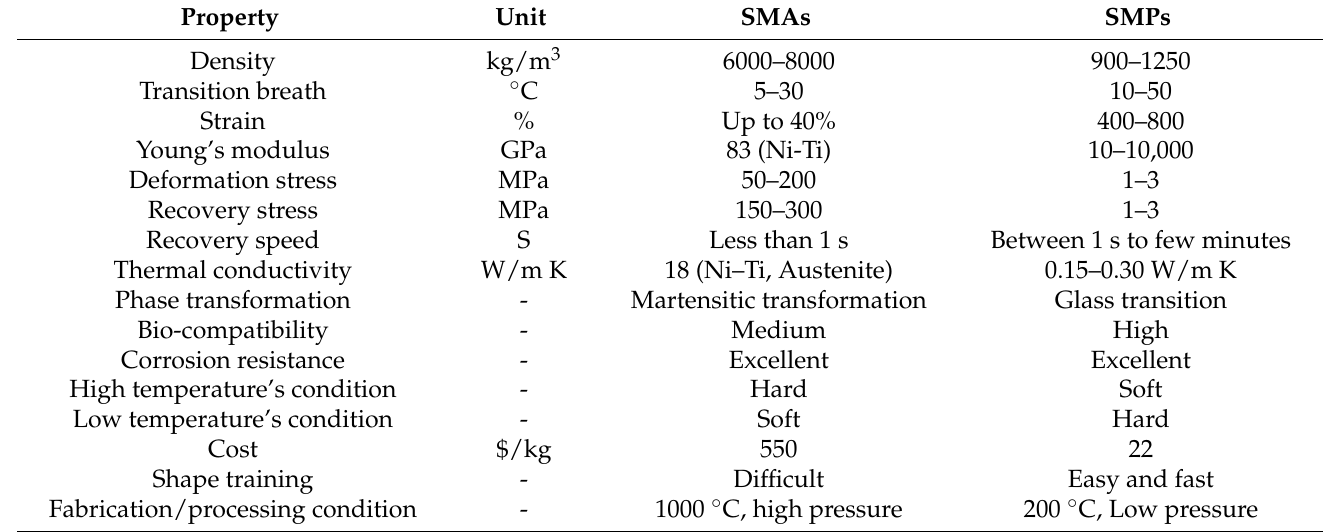
Table 3. Comparison of properties between SMAs and SMPs